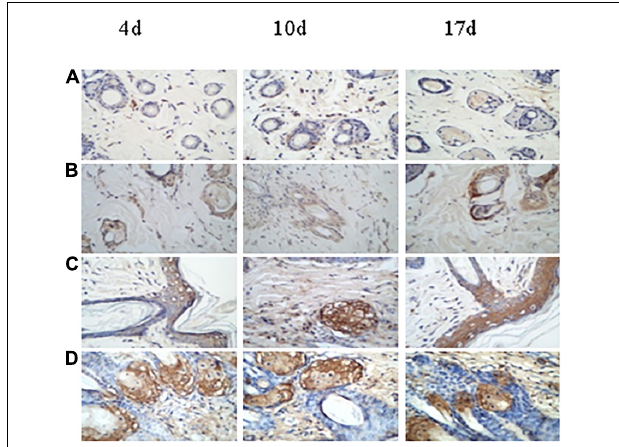
FIGURE 11 | Expression of bFGF in burn wound tissue by time (days post-infection) in treated and untreated rats. (A) Control group. (B) Antibiotic treatment group. (C) aPDT treatment group. (D) aPDT + antibiotic treatment group.